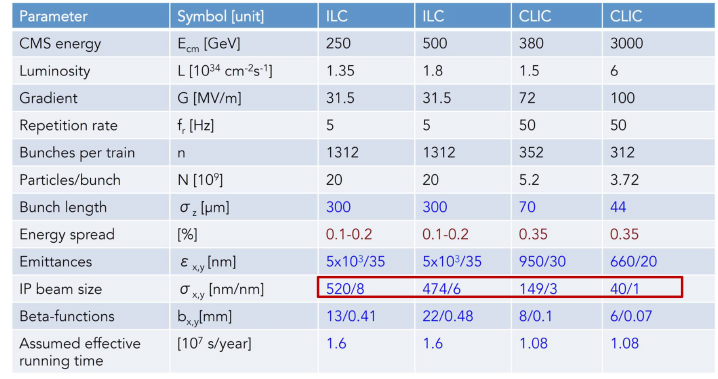
Figure 1. The most relevant parameters of projects of linear colliders